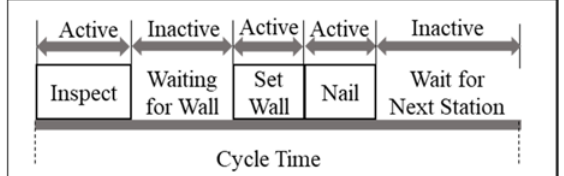
Figure 9. Active periods in a wall-set workstation during a single cycle time.